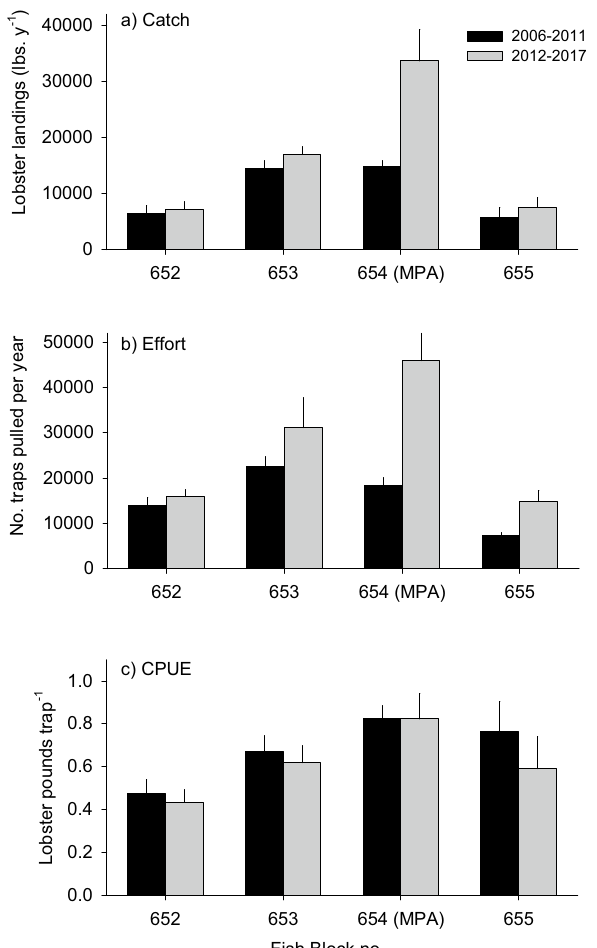
Figure 2. CDFW fishing block data for: ( a ) catch, ( b ) effort and ( c ) catch per unit effort (CPUE) of spiny lobster off the mainland coast of Santa Barbara. Values are means ± SE for the 6-year periods before and after the establishment of MPAs in block 654.